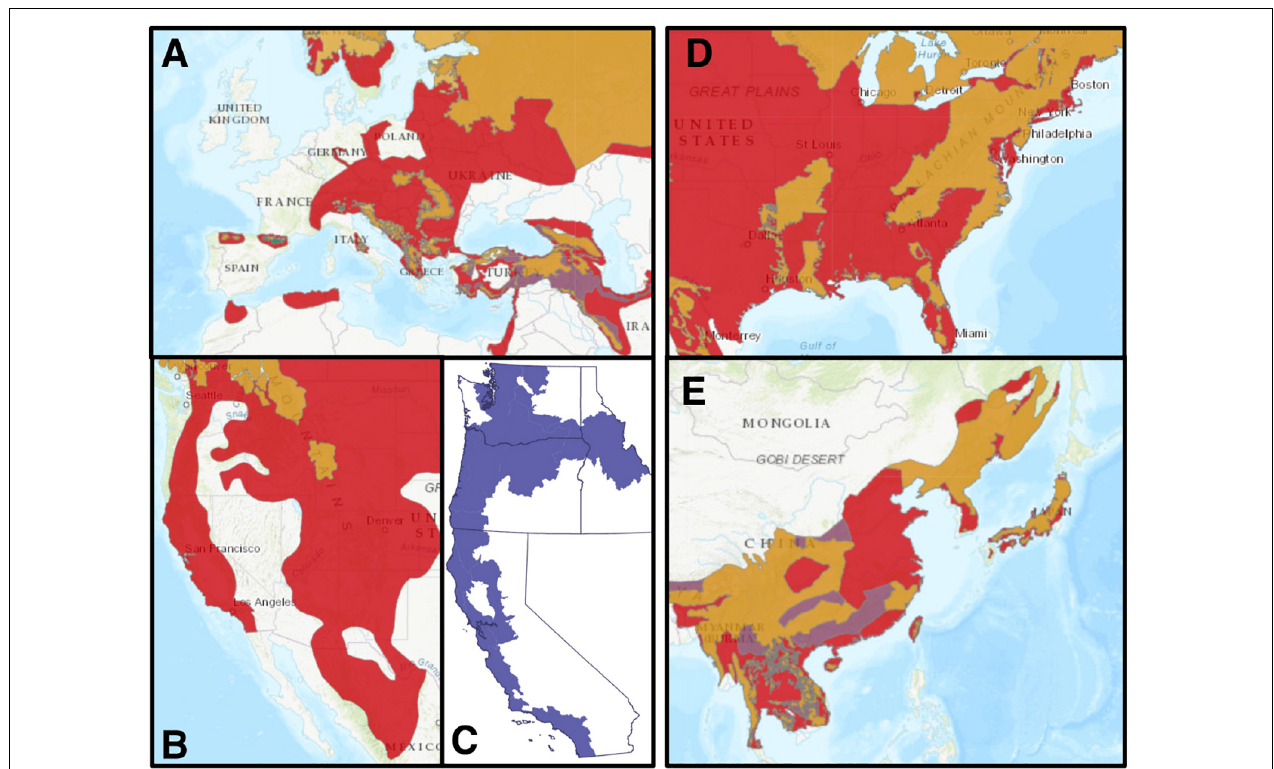
FIGURE 1 | Extant (yellow), possibly extant (purple), and recently extirpated (red; i.e., excluding long-extirpated populations in Europe) bear population distributions from IUCN range maps (IUCN, 2020). Current and former distribution of brown bears in (A) Western Europe and the Mediterranean, and (B) Western United States and Northern Mexico. (C) Current distribution of 28 salmon evolutionarily significant units listed under the Endangered Species Act (five endangered and 23 threatened), highlighting the spatial extent of severe salmon decline. Current and former distribution of (D) American black bears in the Eastern United States and (E) Asiatic black bears in East